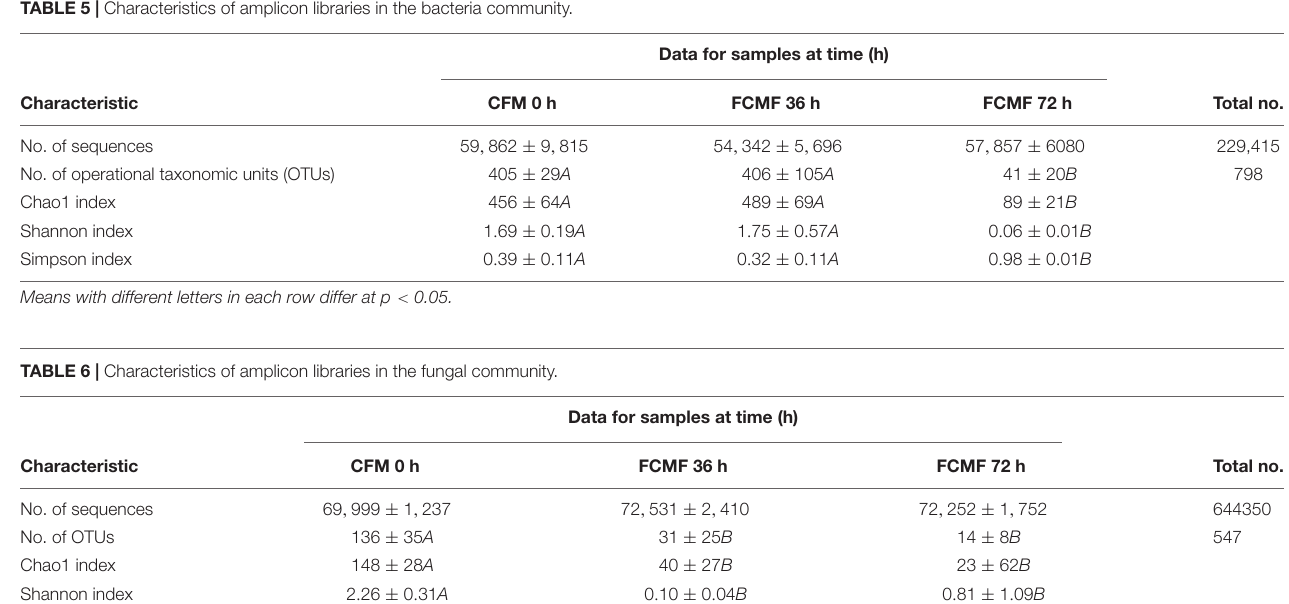
TABLE 5 | Characteristics of amplicon libraries in the bacteria community.